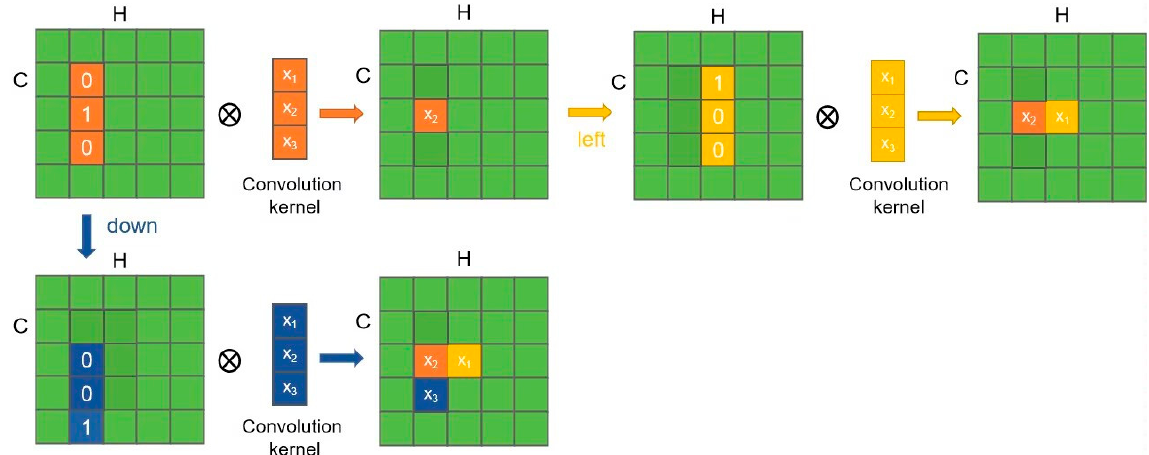
Figure 5. Vertical weight mapping in the VPA module. Convolution kernel slides left and down in the channel dimension for efficient adaptive local cross-channel interaction.